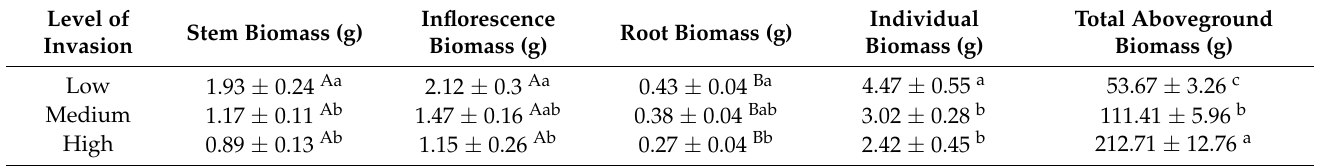
Table 3. Biomass accumulations of Pedicularis kansuensis in different invasion levels.